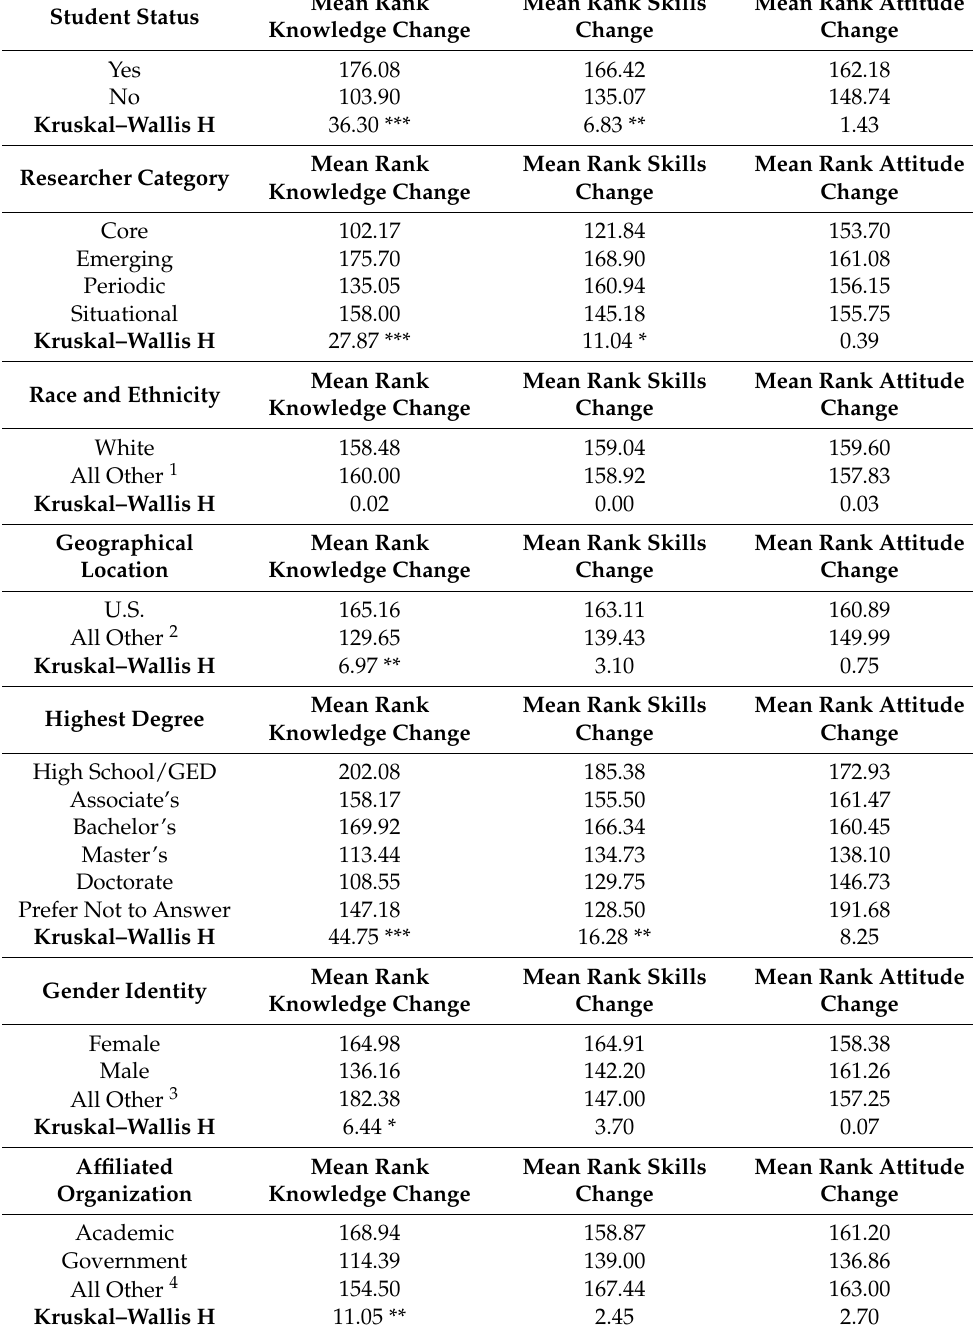
Table 3. Kruskal–Wallis Tests for Change in Knowledge, Skills, and Attitudes across Participant Sociodemographic